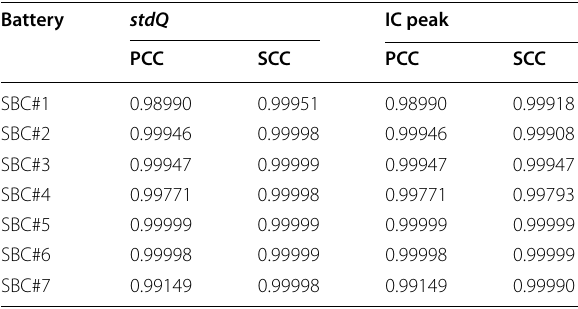
Table A1 Numerical results of the correlation coefficients for